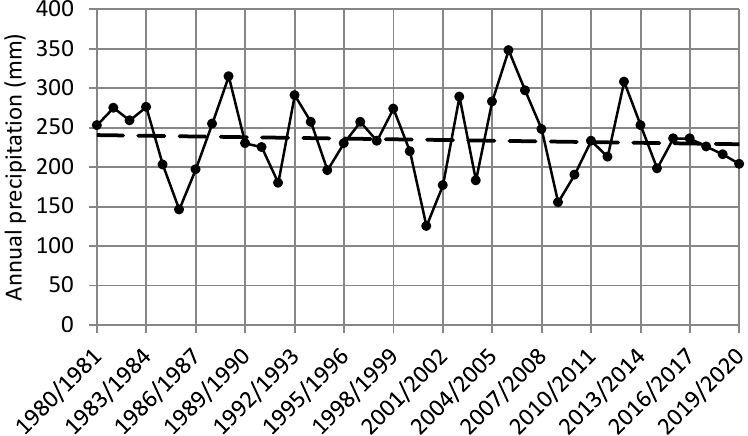
Figure 5. Long-term variability (1981–2019) of annual precipitation in Yakutsk (mm). Linear trend shown by the dotted line.